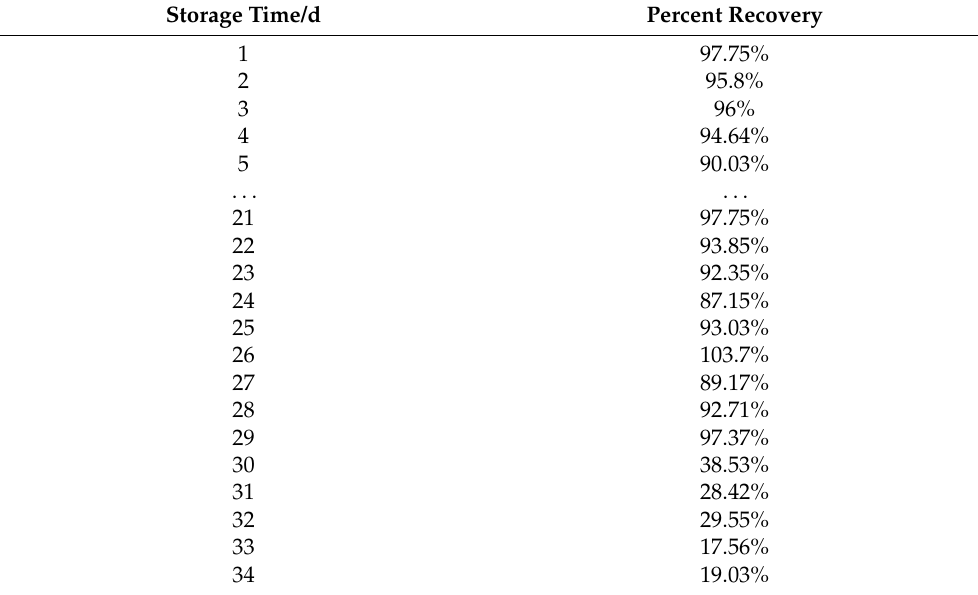
Table 1. Storage time of Cr(VI) in field